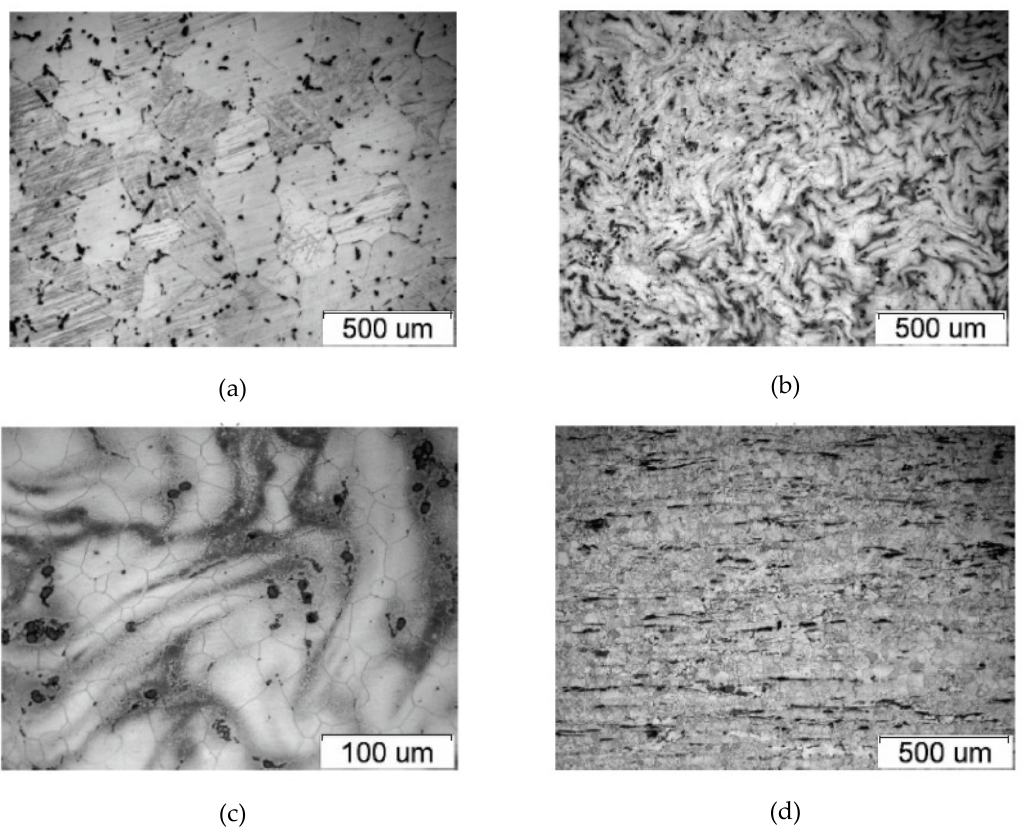
Figure 3. OM micrographs of Mg-Csf composite sections: ( a ) as-cast and hot-extruded, ( b , c ) transverse and ( d ) longitudinal.